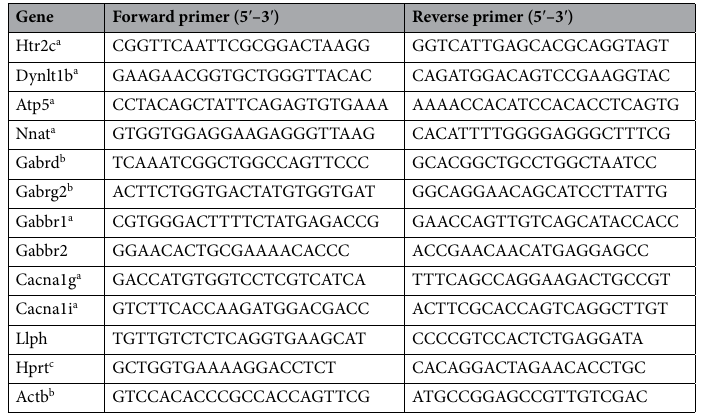
Table 1. Sequences of primer pairs used for qPCR. a OriGene Technologies; b Mendu S.K. et al., PLoS One. 2012;7(8):e42959; c Weiergräber M. et al., Basic Res Cardiol. 2005